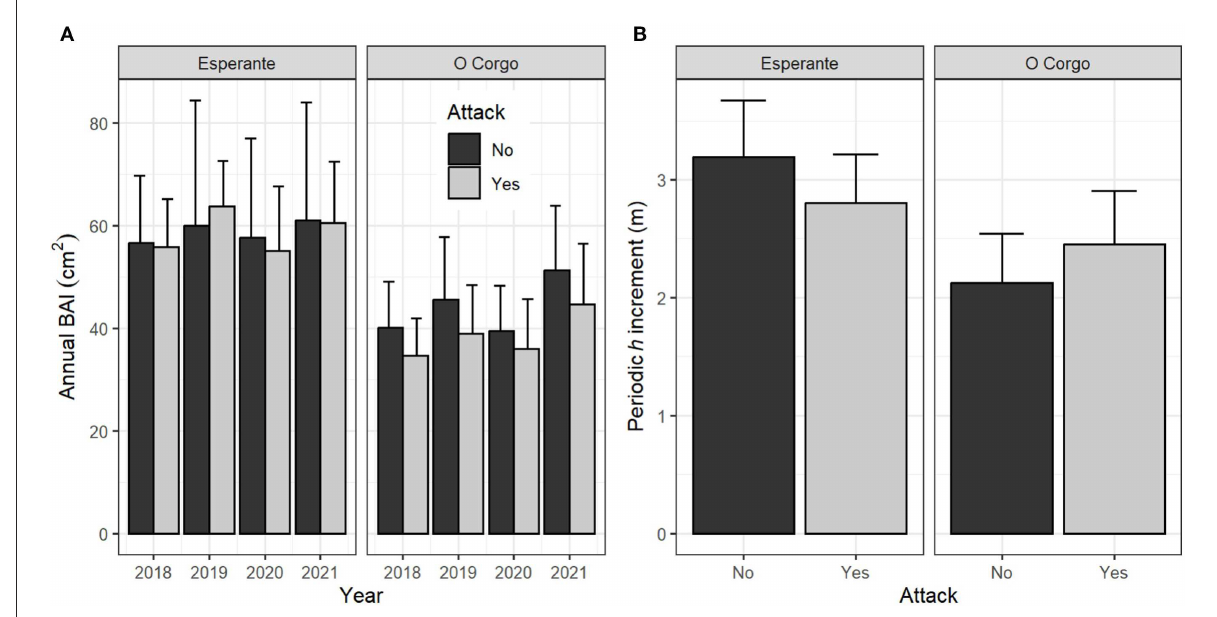
FIGURE3 Bar plot with error bars (SE) for (A) annual BAI, and for (B) the periodic height increment (4-year period) for the two plots that include both attacked and unaffected trees.